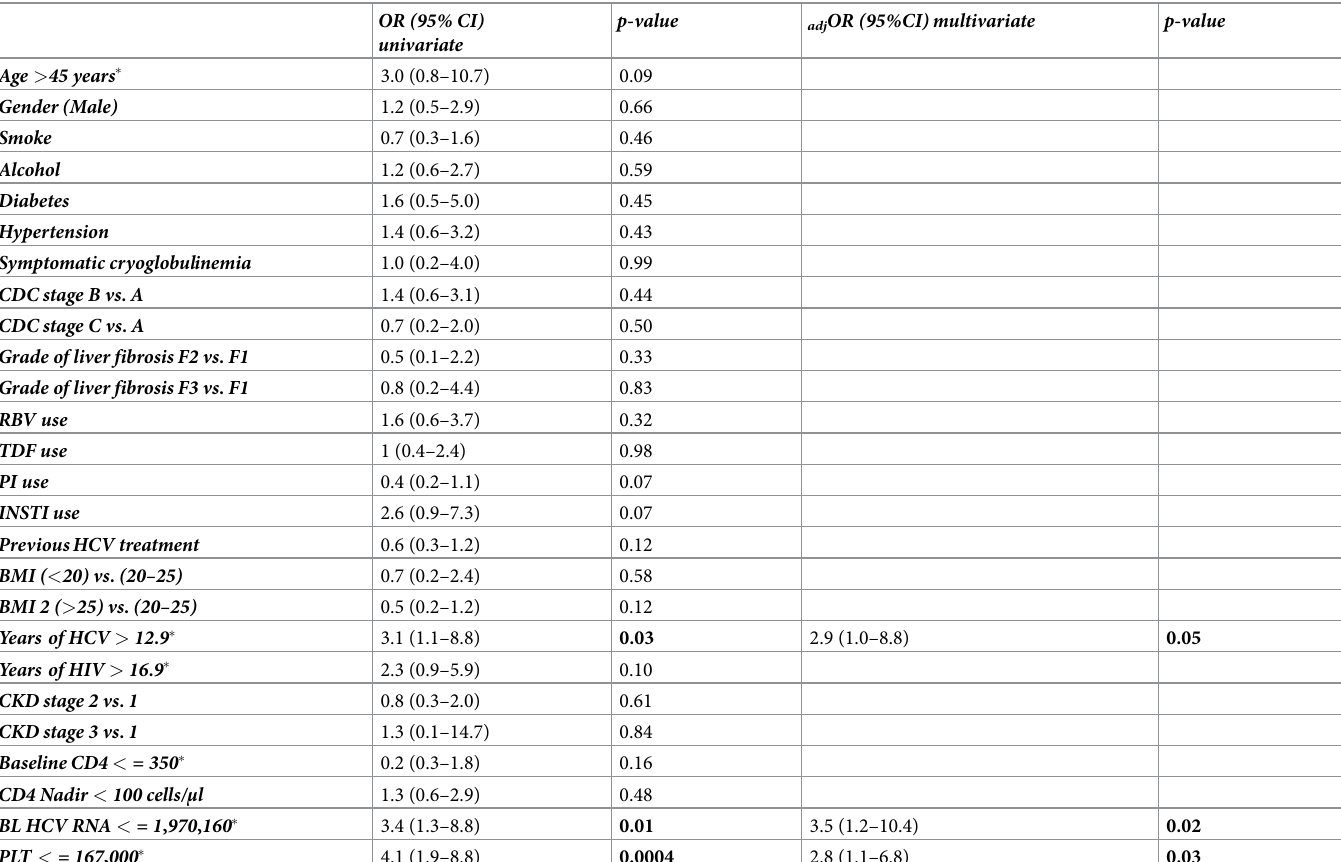
Table 2. Univariate and multivariate predictors of event (eGFR decline > 5%) in the study population (144